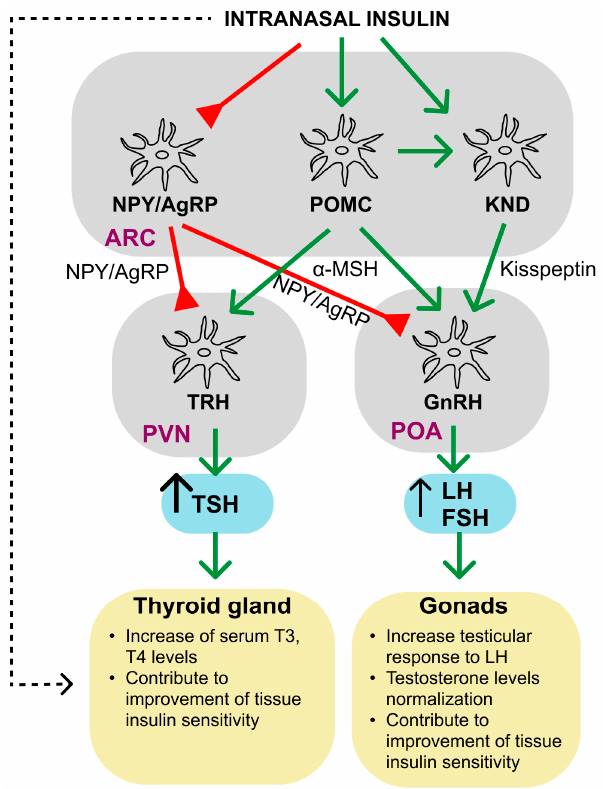
Figure 3. Proposed mechanisms and results of the action of INI in diabetes and metabolic syndrome on the hypothalamic links of the gonadal and thyroid axes. Abbreviations: AgRP—agouti-related peptide; ARC—arcuate nucleus of hypothalamus; FSH—follicle-stimulating hormone; GnRH—gonadotropin-releasing hormone; KND—hypothalamic neurons expressing kisspeptin, neurokinin B, and dynorphin; LH—luteinizing hormone; α -MSH— α -melanocyte stimulating hormone; NPY—neuropeptide Y; PVN—paraventricular nucleus of hypothalamus; POA—preoptic area of hypothalamus; POMC—pro-opiomelanocortin; T3, T4—thyroid hormones, triiodothyronine (T3)